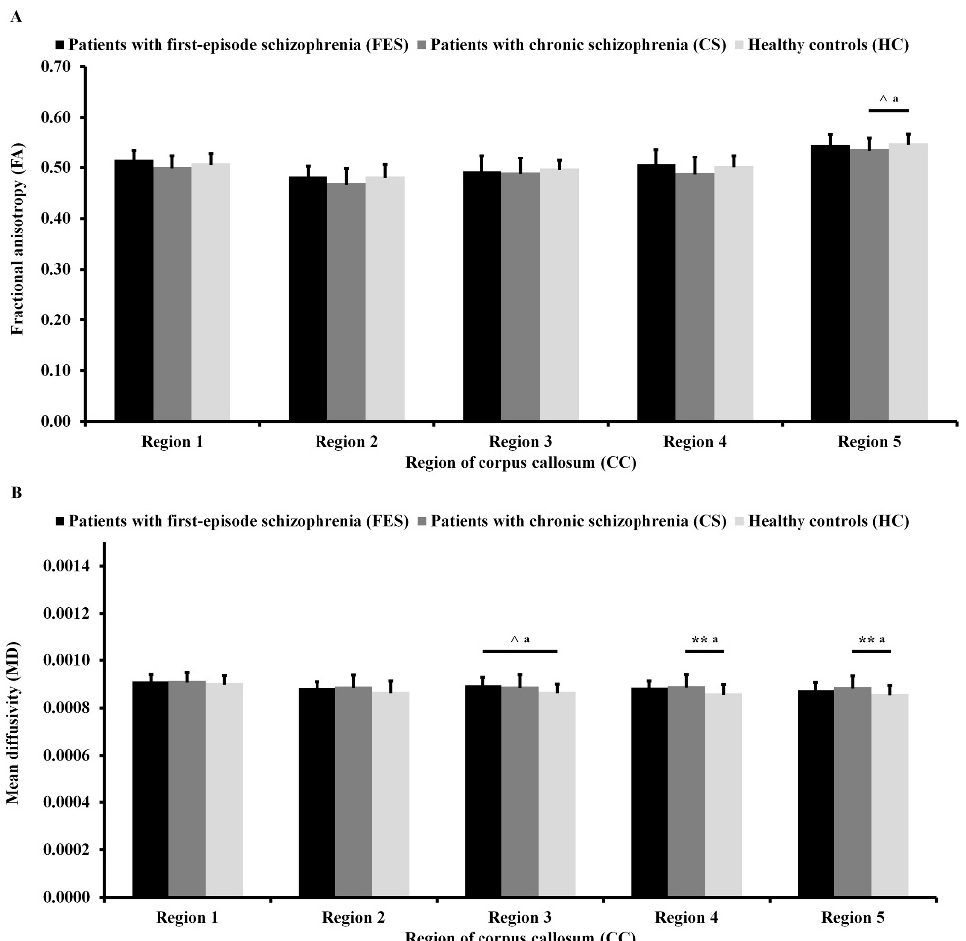
Figure 2. Fractional anisotropy ( A ) and mean diffusivity ( B ) of different regions of the corpus callosum for all participants. a Significant difference after co-varying age. ^ p < 0.1. ** p < 0.01.